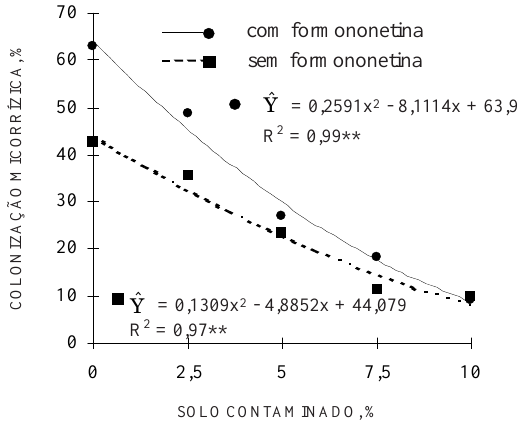
SOLO CONTAMINADO, Figura 2. Colonização micorrízica do milho em função da proporção de solo contaminado com metais pesados e aplicação de formononetina.